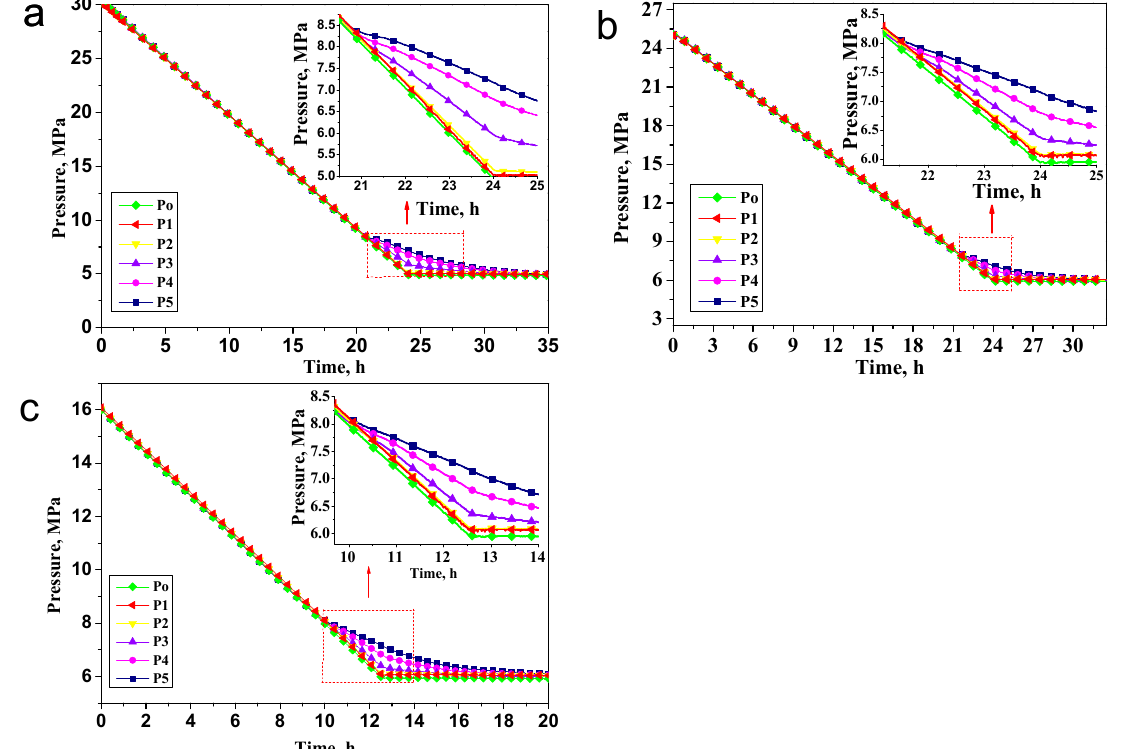
Figure 10. Pressure propagation characteristic of depletion experiments with different pressure depletion range ( a ) pressure depletion from 30 MPa to 5 MPa; ( b ) pressure depletion from 25 MPa to 6 MPa; ( c ) pressure depletion from 16 MPa to 6 MPa.